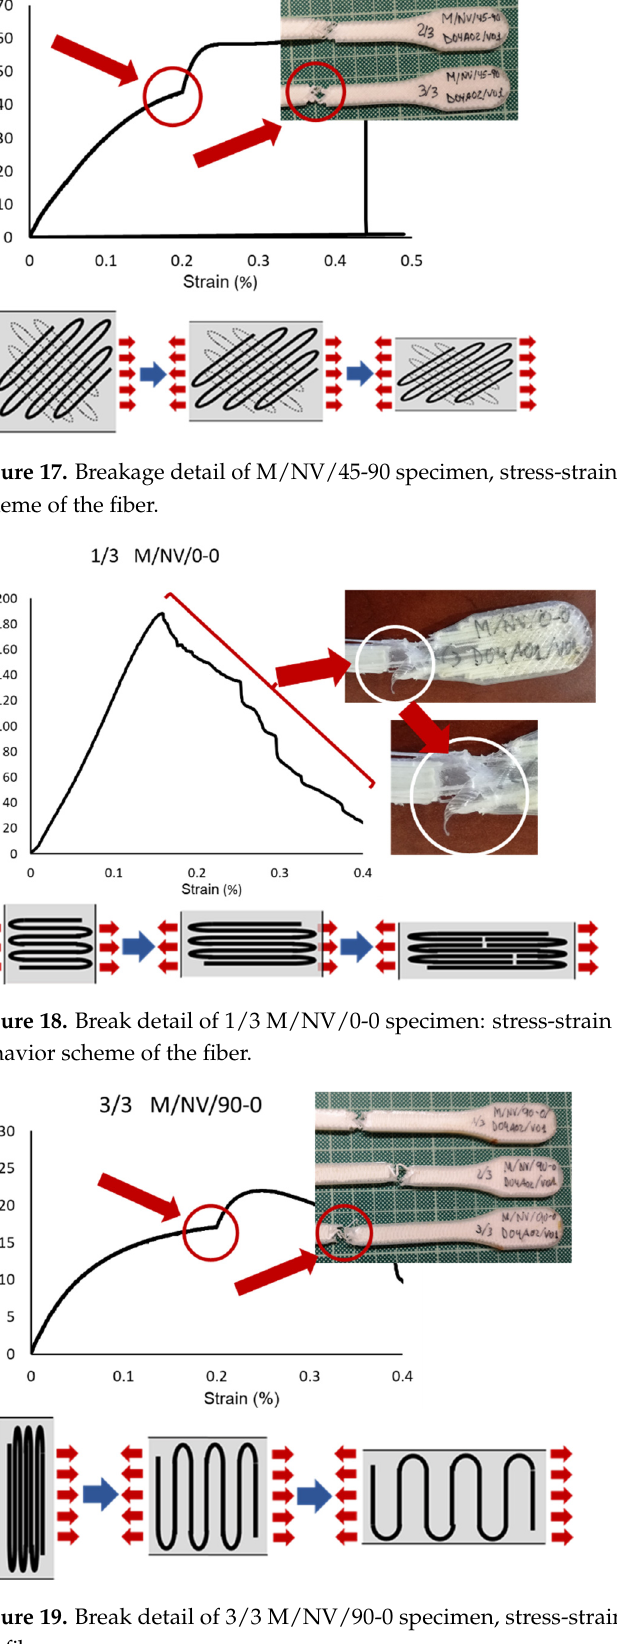
Figure 19. Break detail of 3/3 M/NV/90-0 specimen, stress-strain graph and “spring” behavior of the fiber. the